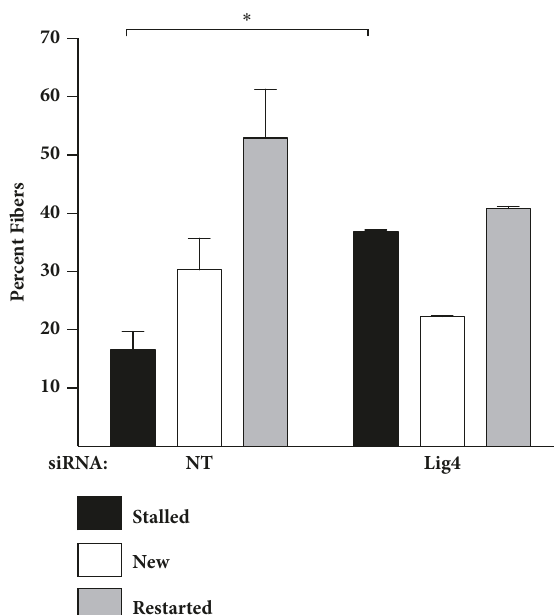
Figure 4: Lig 4 d epletion alters b asal levels of replication. (a, b) BT549 cells were treated with siRNA targeting either Lig4 or scrambled control (NT) and DNA replication was assessed using the DNA fiber assay. Briefly, cells were sequentially pulsed with thymidine analogs IdU and CldU and the DNA fiber assay was conducted [10]. For each treatment, stalled, new and restarted replication forks were scored after blinding for treatment. Percentof stalled, new and restarted replication forks in Lig4 depleted cells were compared with respectiveNT control cells ( ∗ p < 0.05).